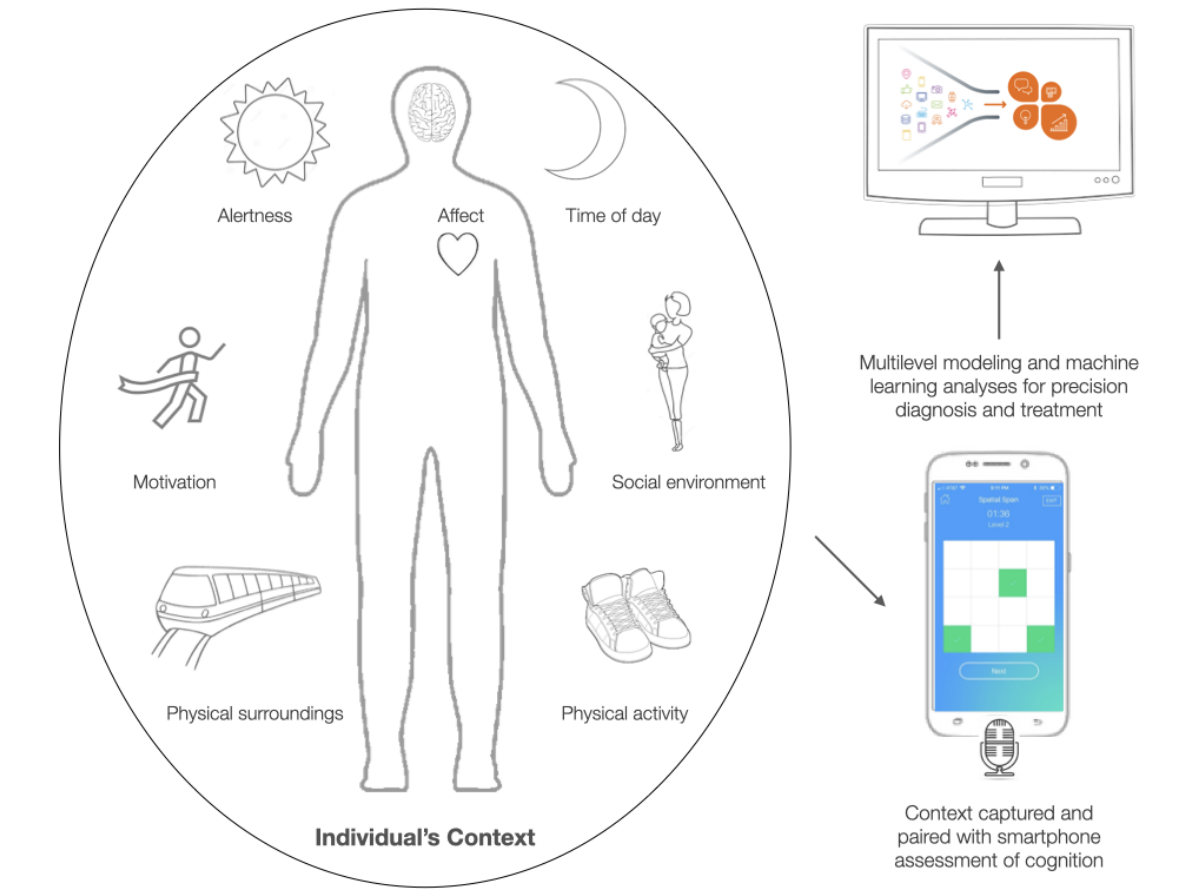
Figure 2. Model of mobile assessment of intraindividual variability in cognition. Internal state-driven variables include affect motivation and alertness. External contextual variables include time of day, social environment, physical surroundings, and physical activity. Taken together, these factors give rise to fluctuations in cognitive performance. This can be captured in real time using a game-like smartphone assessment of cognition alongside sensing tools such as a smartphone microphone and GPS, which seamlessly capture information about one’s environment. Advanced statistical methods can be used to analyze data to find patterns of intraindividual variability in cognition in real-world